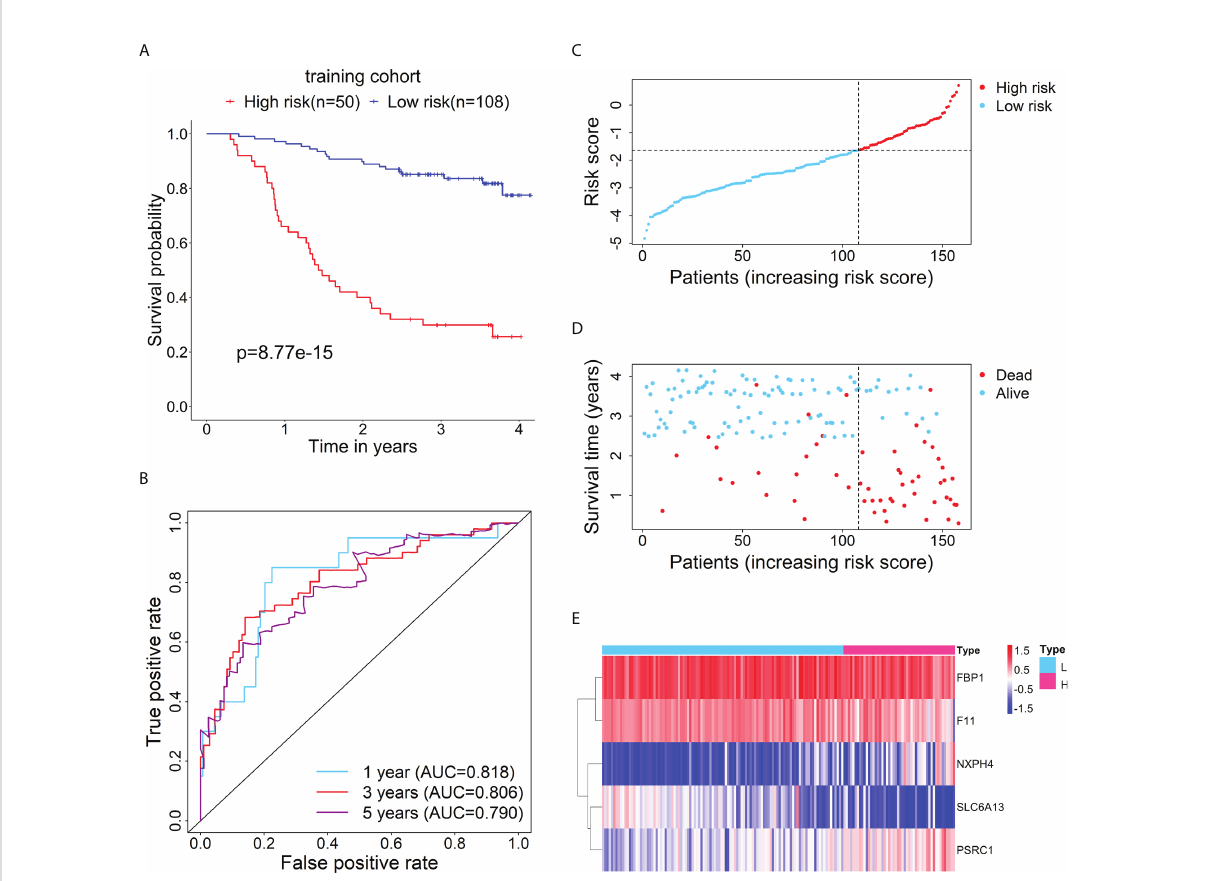
FIGURE 2 Evaluation of the prognostic performance of the RBP-related risk model in the training cohort. (A) Kaplan – Meier curve shows the difference in OS between the high- and low-risk groups in the training cohort. (B) The 1-, 3-, and 5-year ROC curves based on the risk score show the accuracy of the prognostic prediction of the RBP-related risk model. (C) The distribution of risk scores of patients in the high- and low-risk groups. (D) The distribution of survival time and status of patients in the high- and low-risk groups. (E) Heatmap of clustering analysis for the expression of fi ve RBP-related mRNAs in the high- and low-risk